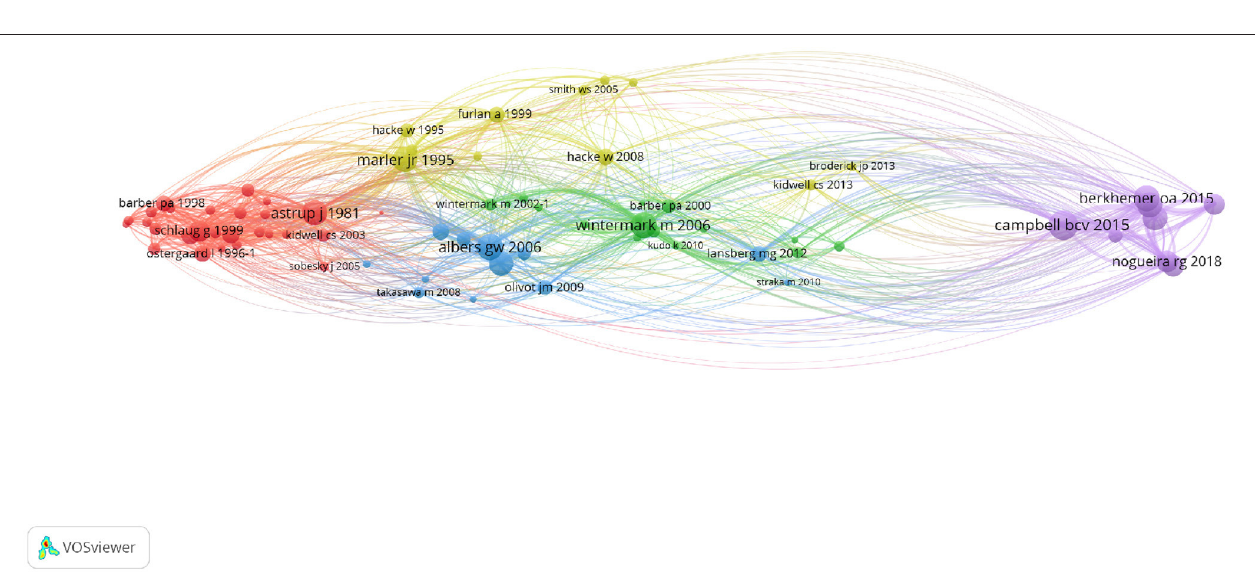
time windows [DIAS (66), DIAS-2 (67) and EPITHET (68)]